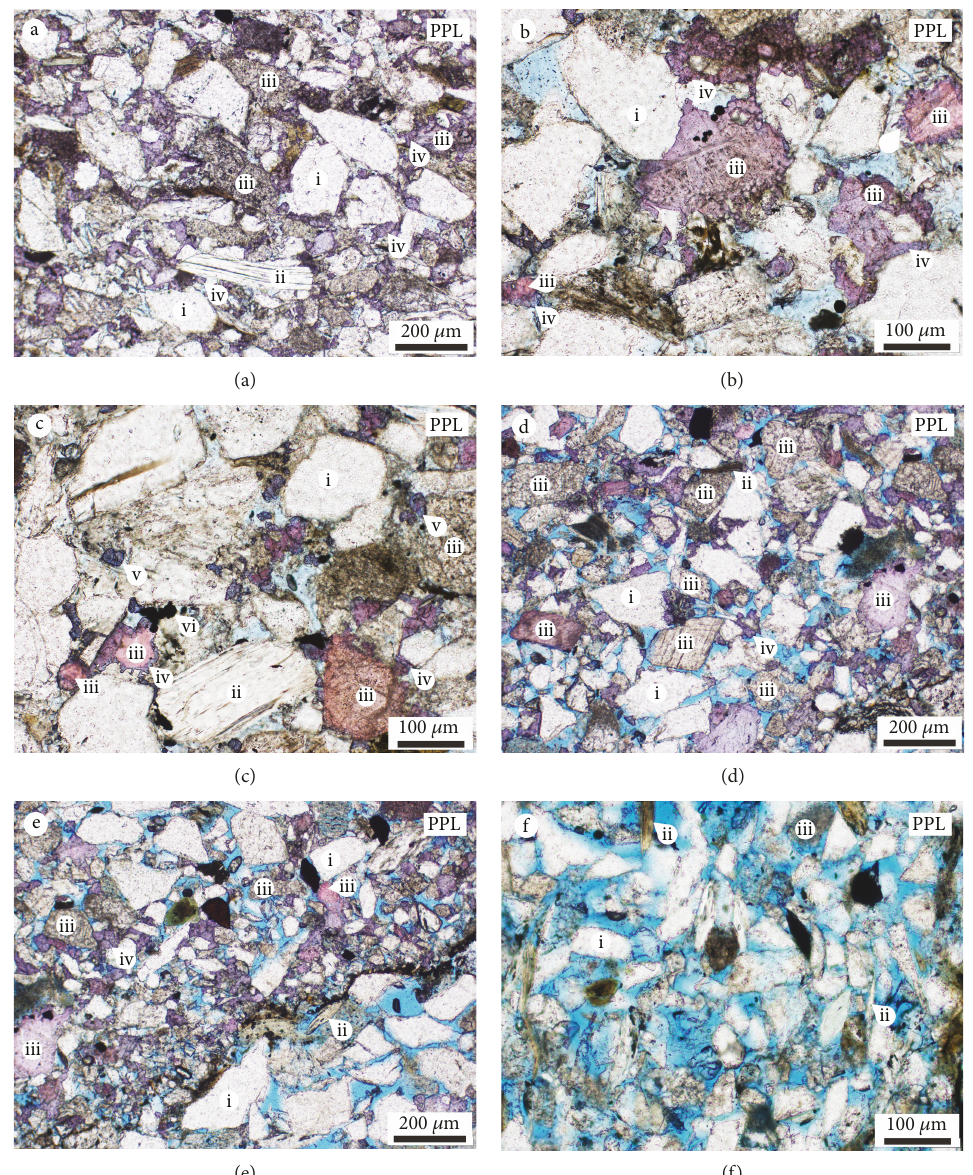
Figure 8: Micropetrographic characteristics of the studied sandstone and siltstone samples. (a – e) Pervasive to patchy cemented sandstones (a – c: 1/2; d and e: 1/4; f: 3/3). Well-cemented zones can grade to poorly cemented zones over distances of a few tens of micrometers. Pores are fi lled by blue epoxy resin. Dominant framework grains: quartz (i), micas (ii), and carbonate lithics (iii, note: limestone clasts and detrital calcite crystals show red or pinkish color after staining but dolomite is unstained); dominant cements: Fe calcite (iv), ankerite (v), and framboidal pyrite aggregates (vi). (f) Poorly cemented sandy siltstone sample with locally high ( ~ 20 – 25%) porosity. Abbreviation: PPL=plane polarized